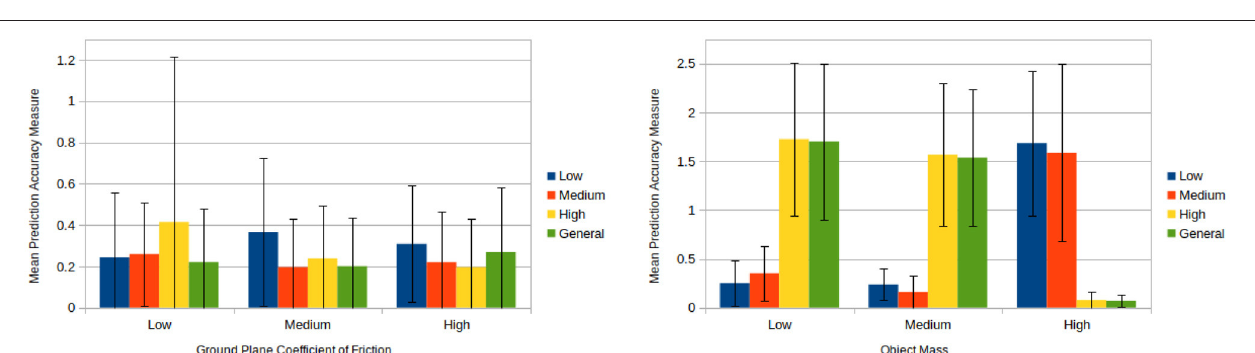
FIGURE 9 | (Left) Mean prediction accuracy measures each over 100 pushes produced by friction biasing experimentation for each model and condition (see section 8.3). The unbiased models (green) perform reasonably well in all conditions, although improvements can be achieved with biased predictors, e.g., high and medium models in high friction condition. (Right) Mean prediction accuracy measures each over 100 pushes produced by mass biasing experimentation for each model and condition (see section 8.3). The plot shows that the mass distribution has an higher impact on the predictions than the friction, and highlights more